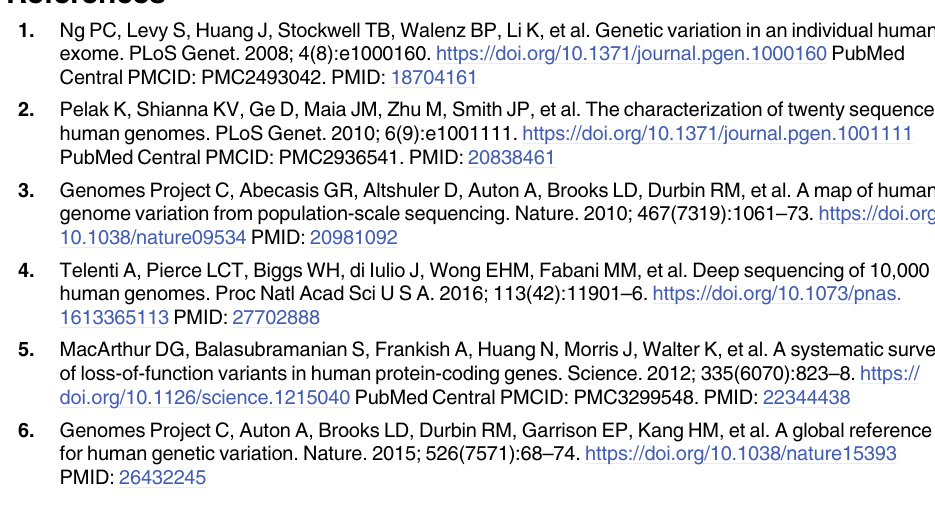
S2 Table. Predicted LoF-tolerance scores for all enhancers in this study, and feature impor- tance of the model. S3 Table. Genes regulated by LoF-tolerant and low-LoF-tolerance enhancers.